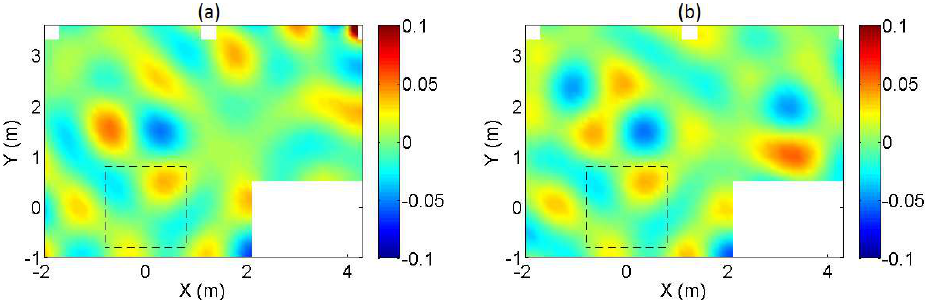
Figure 5. Target ( a ) and reconstructed ( b ) field of the reference room, 250 Hz.